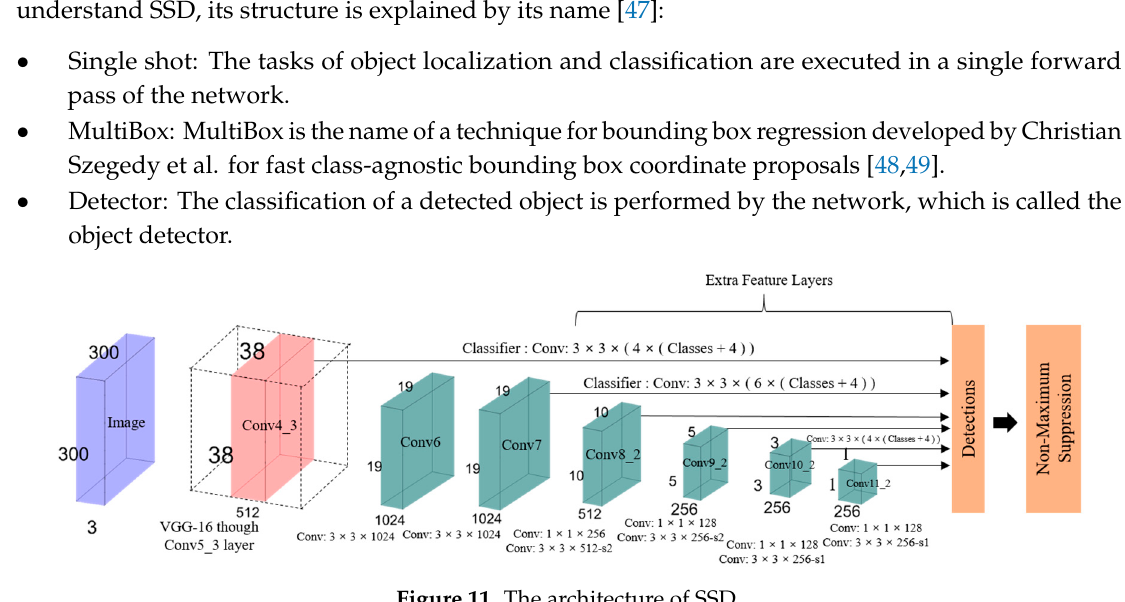
Figure 11. The architecture of SSD.